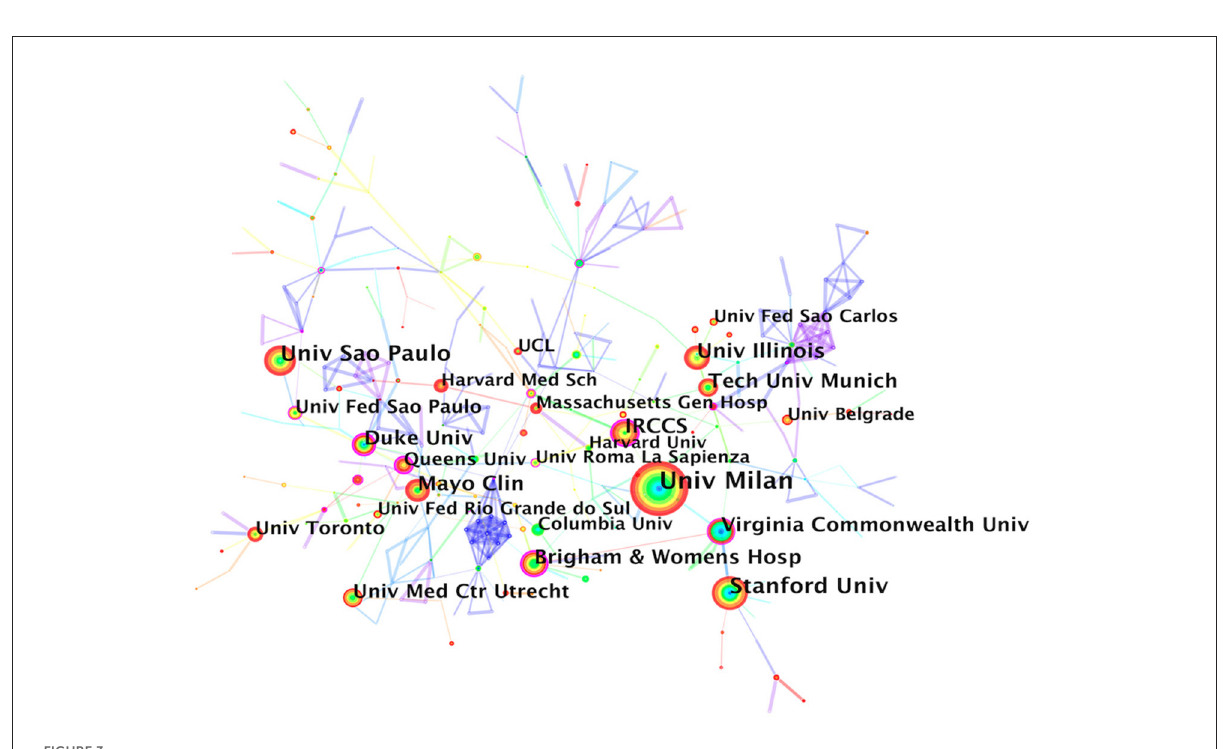
FIGURE3 Institution collaborative network